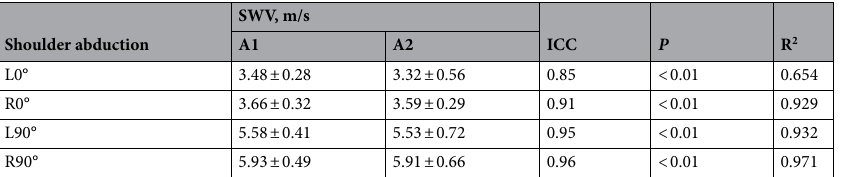
Table 2. Intra-operator reproducibility of mean shear wave velocity of the MD at various arm abduction. A1 Operator A first measurement, A2 operator A second measurement, SWV mean shear wave velocity, ICC intra-class correlation coefficient, R 2 = goodness of fit. Data are presented as mean ± standard deviation where applicable.